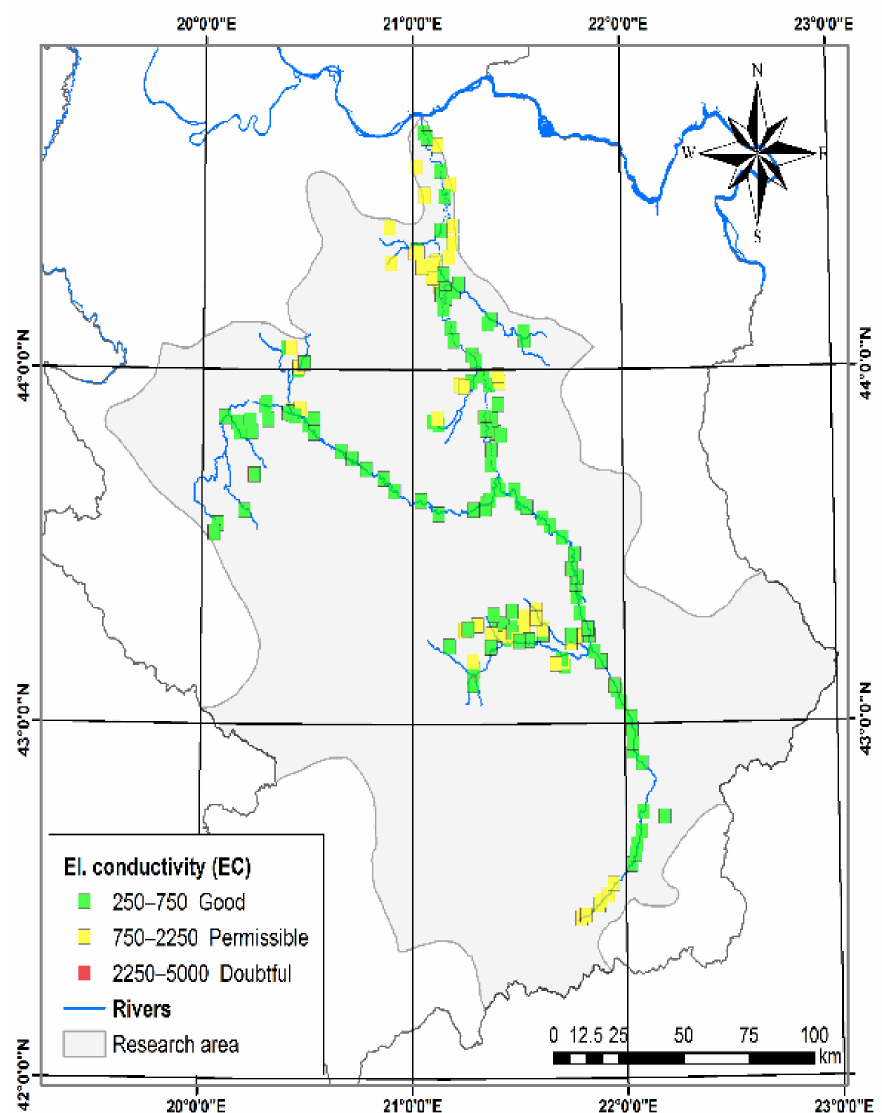
Figure 4. Spatial distribution maps of